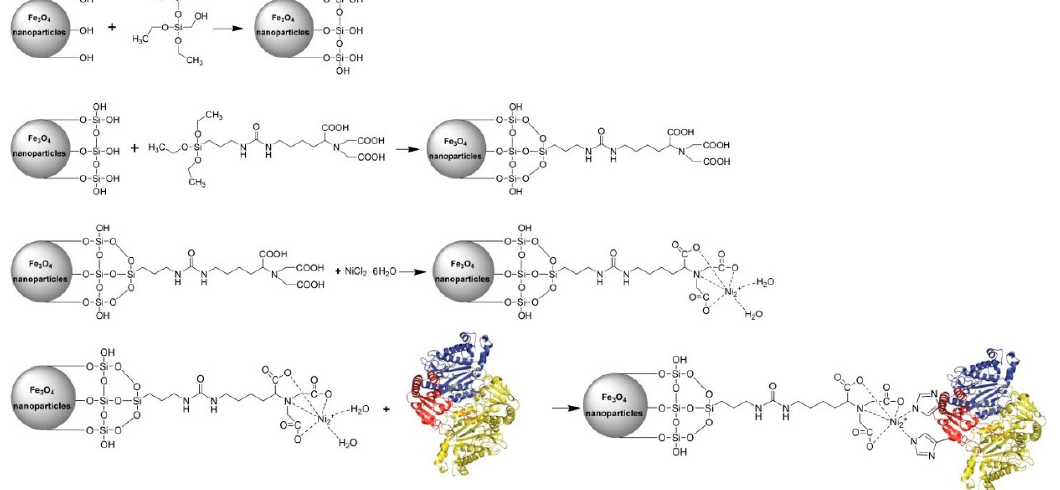
Figure 1. Synthetic procedure of Ni 2+ -functionalized silica-coated magnetic nanoparticles Figure 1. SyntheticprocedureofNi 2 + -functionalizedsilica-coatedmagneticnanoparticles(NiNTASiMNPs) (NiNTASiMNPs) and the strategy employed to immobilize His 6 - Ec PepQ. and the strategy employed to immobilize His 6 - Ec